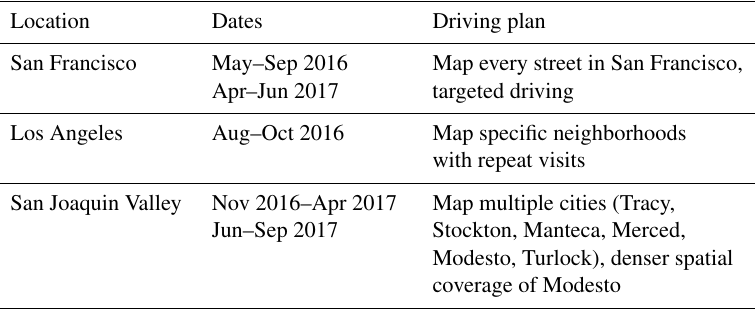
Table 1. Summary of driving dates and plans.